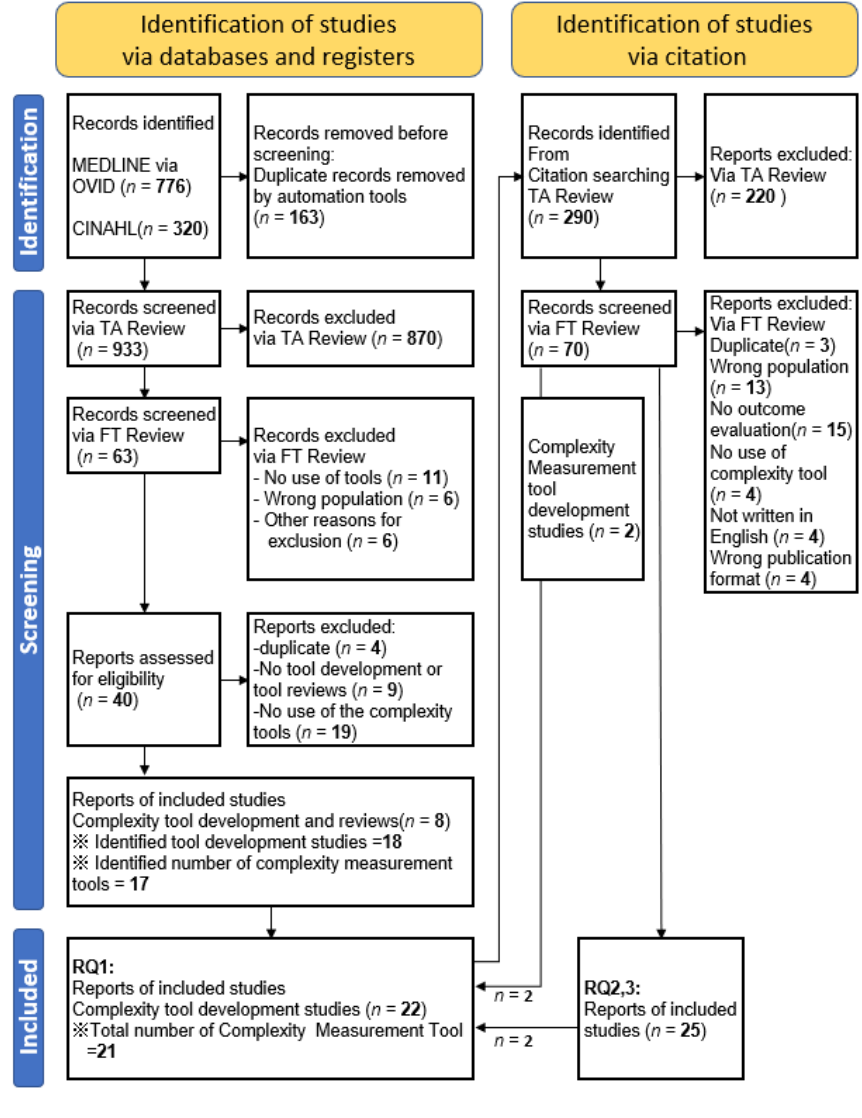
Figure 1. PRISMA flow chart.